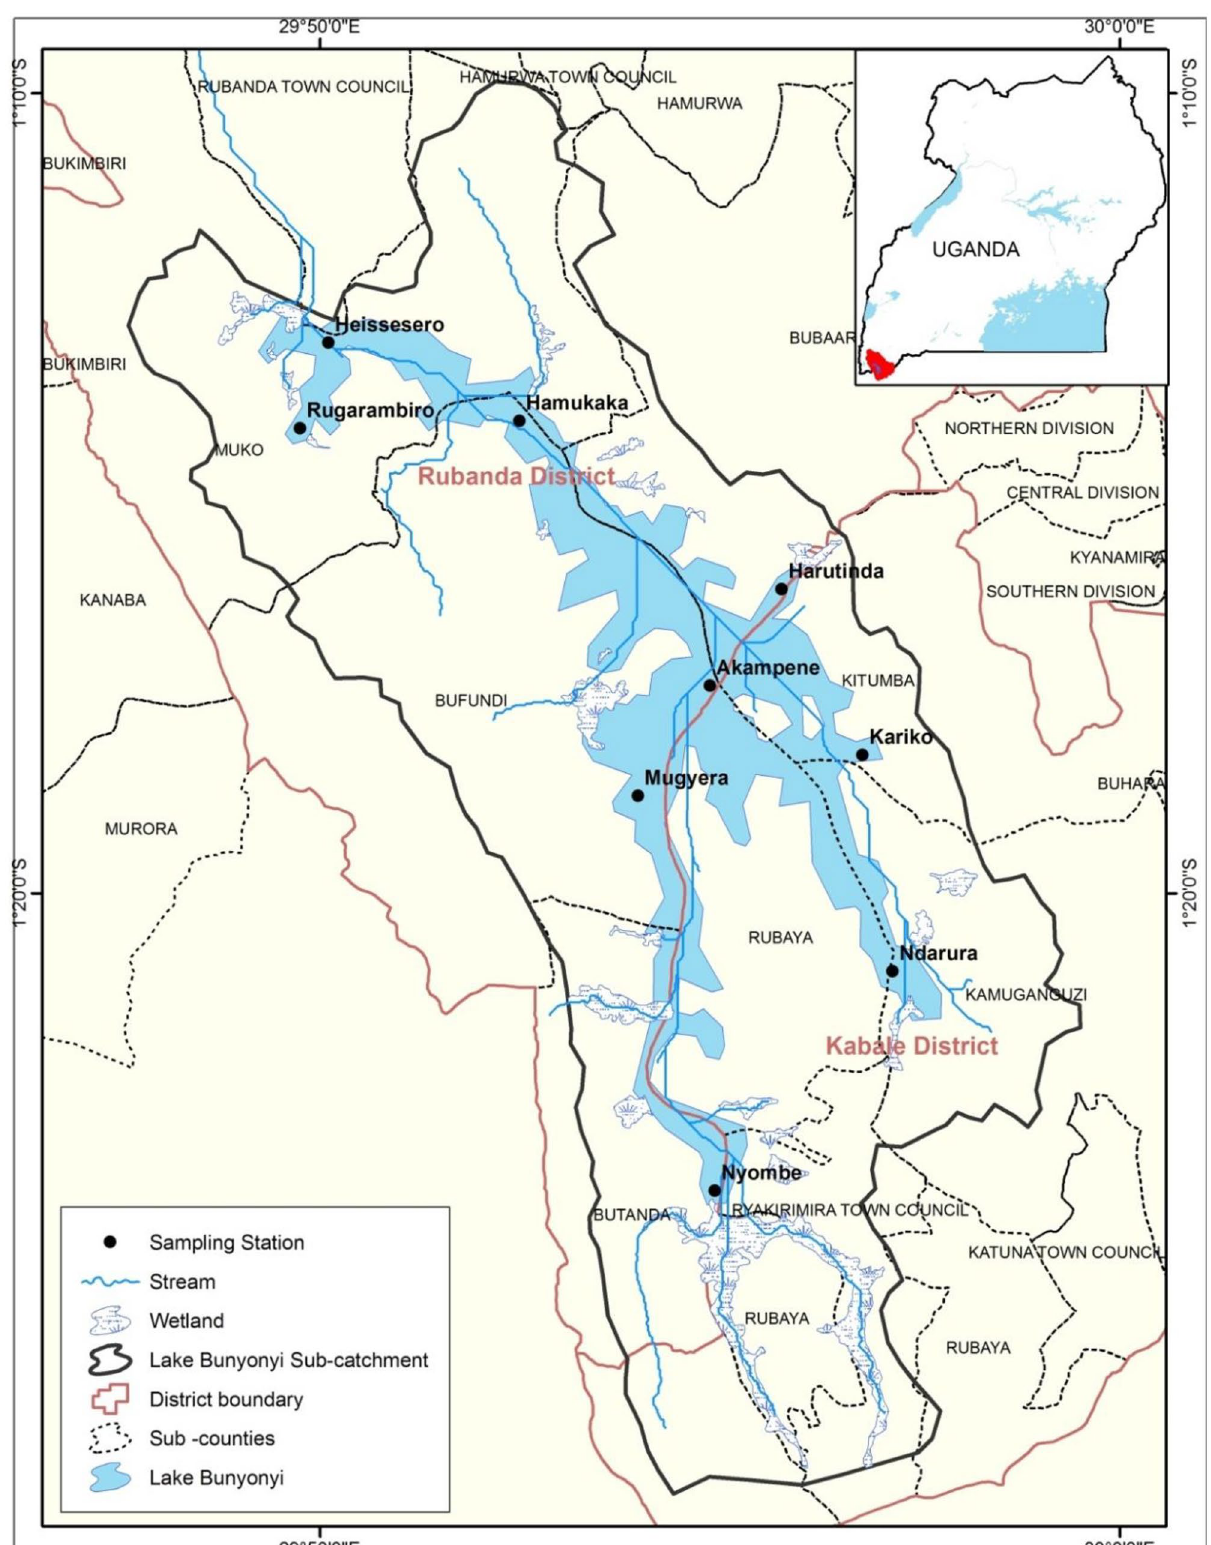
Fig. 1 Location Map of Lake Bunyonyi, Southwestern